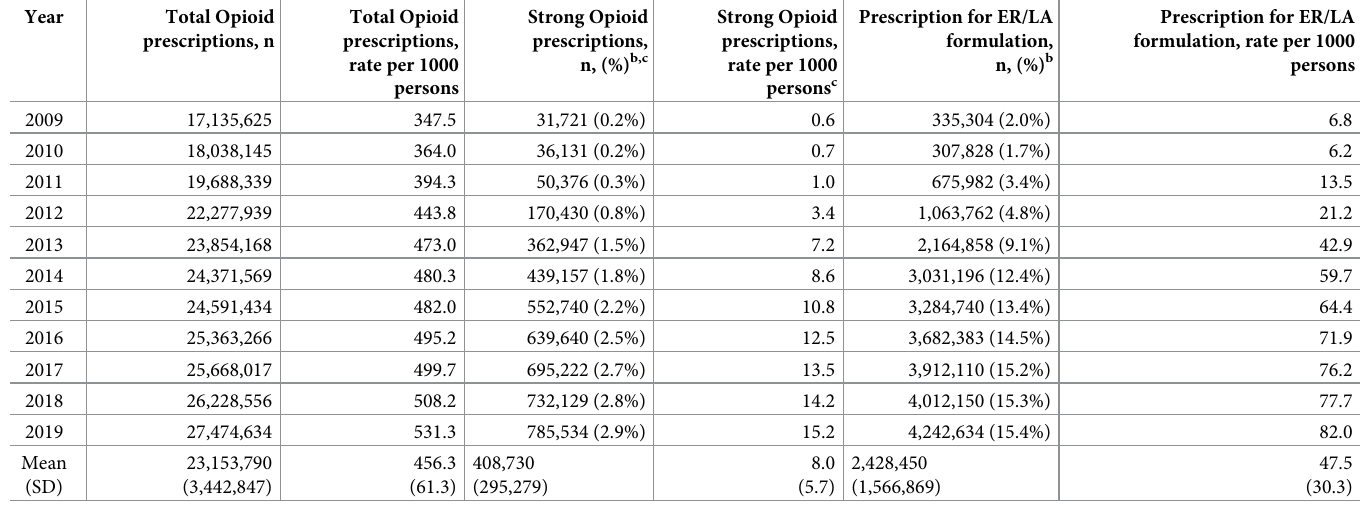
Table 1. Annual opioid prescriptions for the three key measures in South Korea, 2009–2019 a